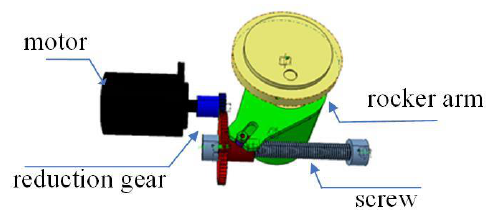
Figure 1. Schematic diagram of an electric rudder